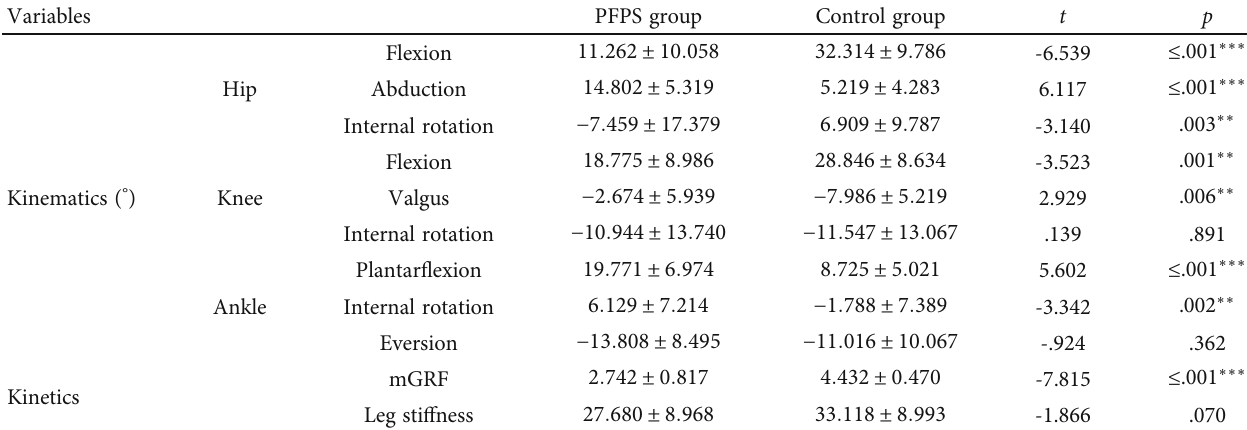
Table 2: Results of kinematics and kinetics at maximum ground reaction force.